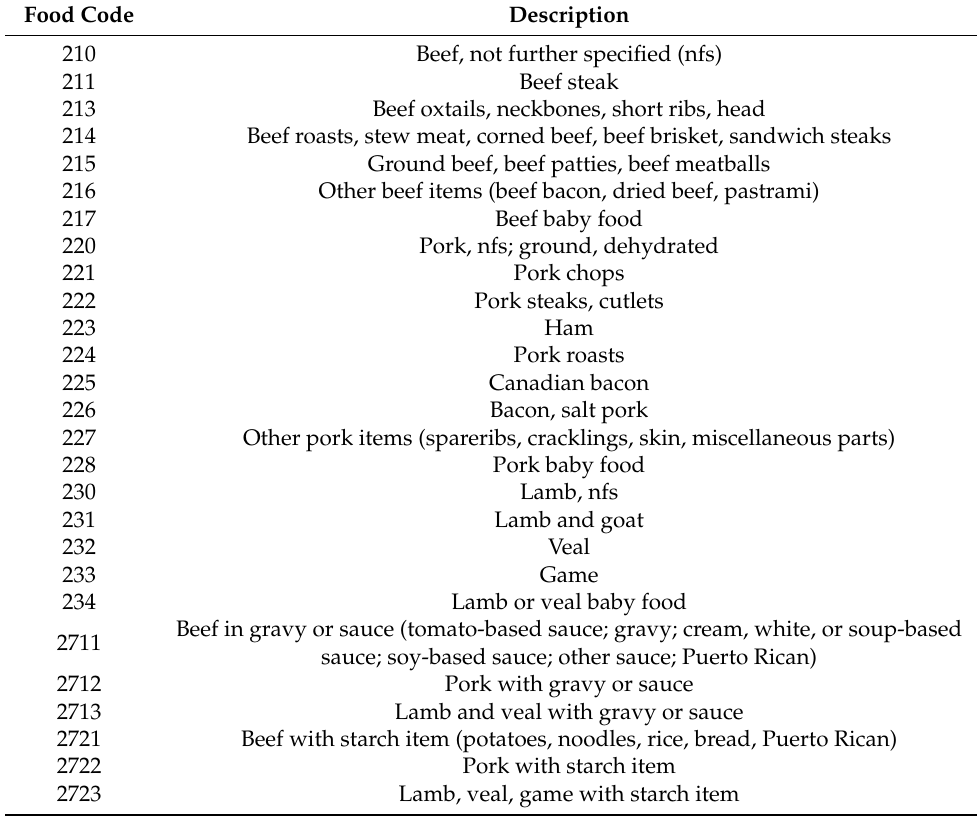
Table A1. Meat types considered as red